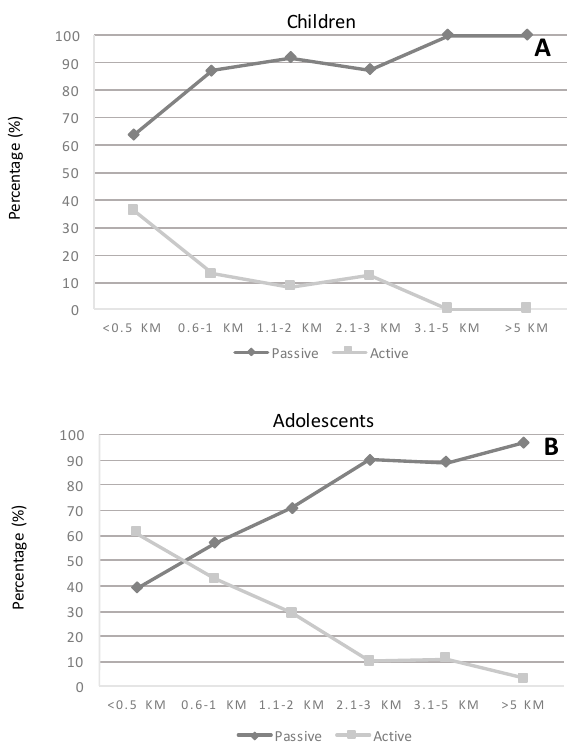
Figure 2. Distances from home to school according to active or non-active modes of commuting in children ( A ) and adolescents ( B ).